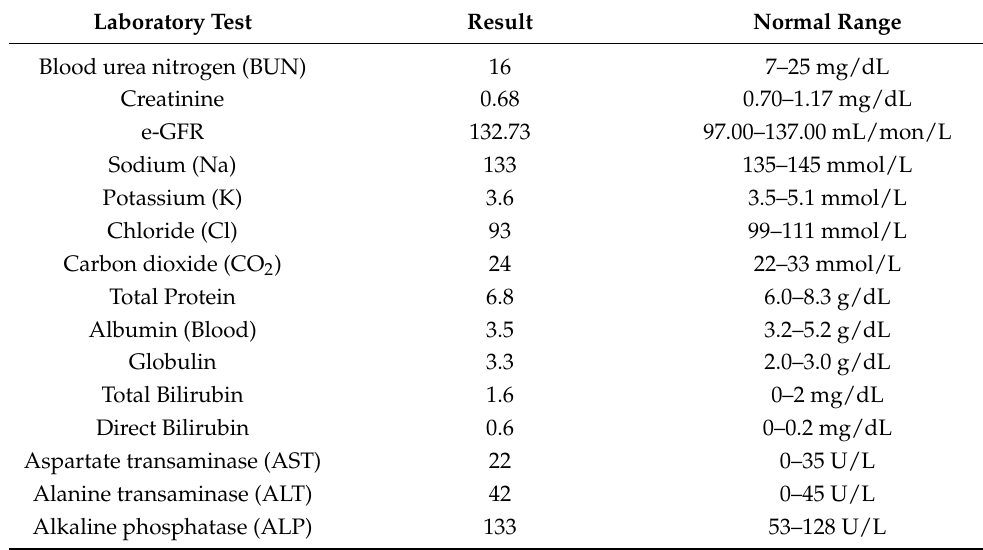
Table 2. Blood chemistry results at